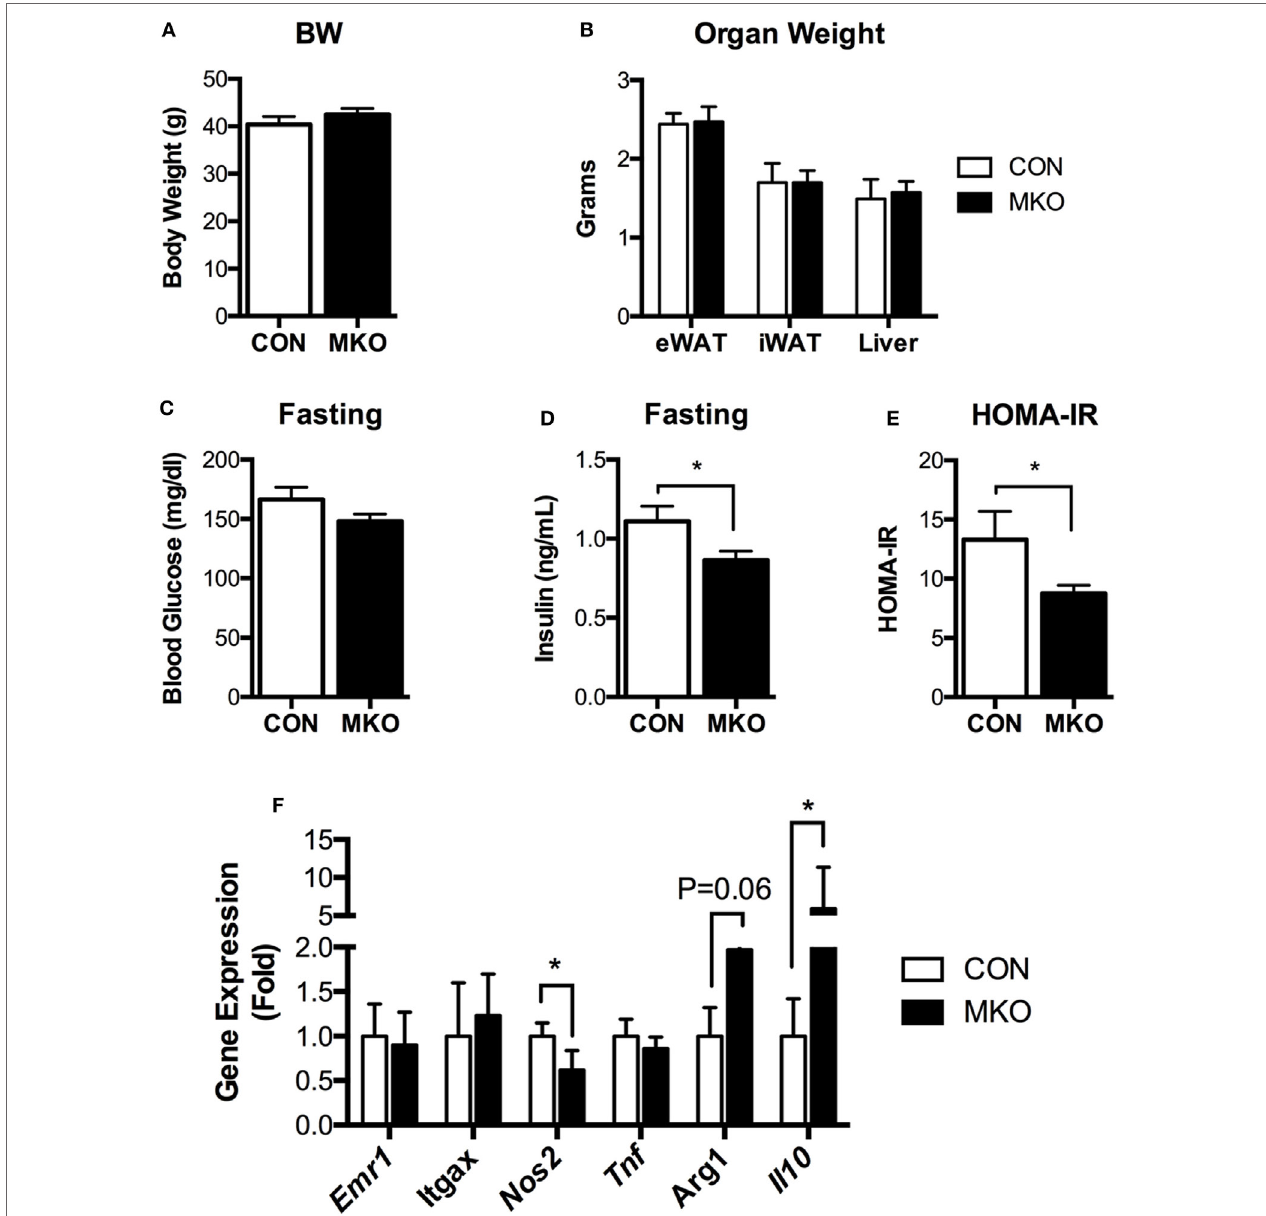
FigUre 6 | Deletion of Lmna in myeloid tissues attenuates high-fat diet-induced insulin resistance in mice. CON and myeloid cell-specific Lmna KO mice (MKO) male mice (6 weeks) were fed a high-fat diet (HFD) for 12 weeks (CON, n = 4; MKO, n = 9). (a) Body weight, (B) organ weights of epididymal white adipose tissues (eWAT), inguinal white adipose tissue, and liver, (c) fasting blood glucose, (D) fasting plasma insulin, (e) homeostatic model assessment for insulin resistance index, (F) gene expression in eWAT from CON and MKO mice. Error bars represent SEM. * p <